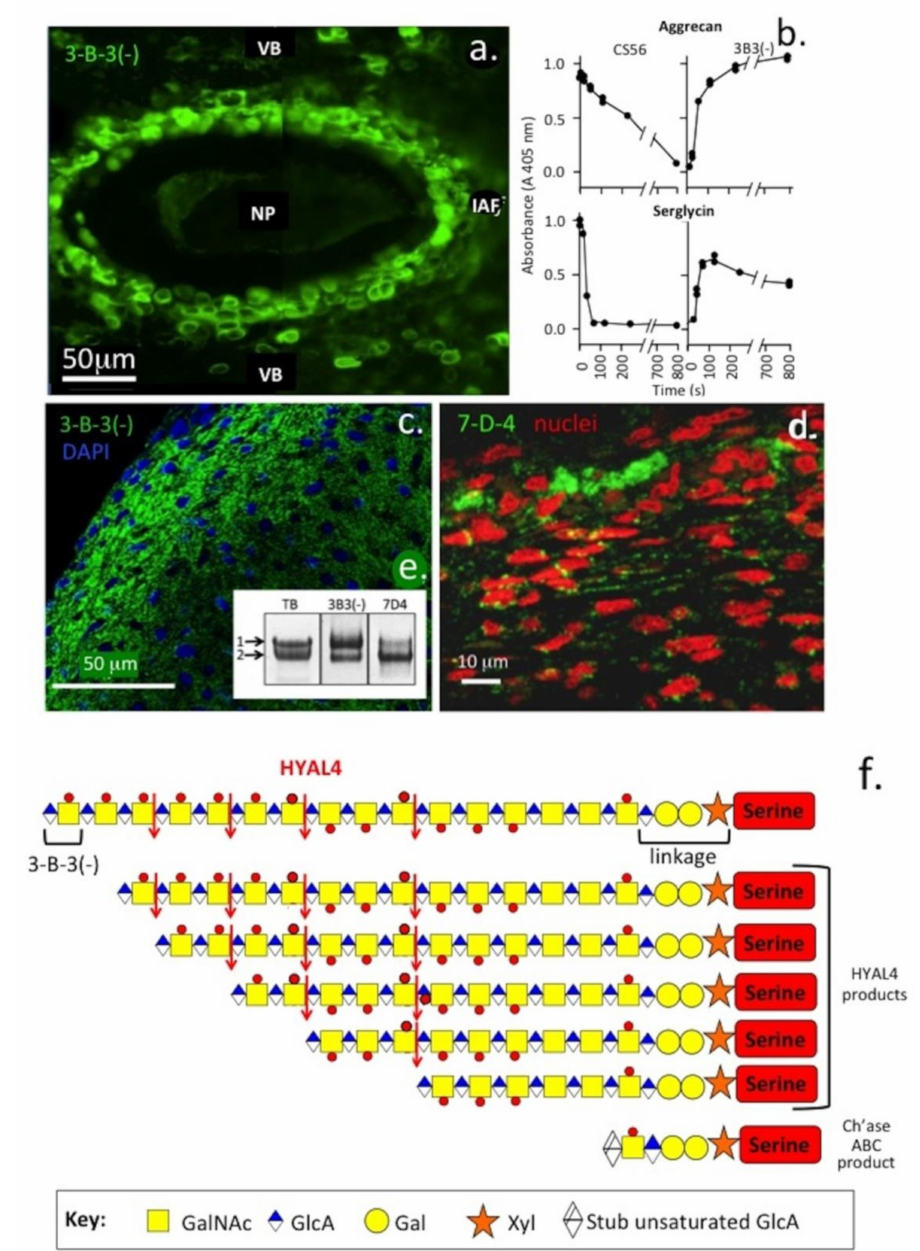
Figure 2. Immunofluorescent localisation of the 3-B-3( − ) CS sulphation motifs on aggrecan associated with rudiment cartilage of a rat intervertebral disc ( a ) and demonstration of the generation of the 3-B-3( − ) epitope by digestion of aggrecan and serglycin as model proteoglycans with hyaluronidase-4 (HYAL4) ( b ). Immunolocalisation of the 3-B-3( − ) and 7-D-4 CS sulphation motifs in developmental human foetal knee joint cartilage (14 weeks gestational age) ( c , d ). The inset of ( e ) shows foetal aggrecan samples separated by native composite agarose polyacrylamide gel electrophoresis and blotted to nitrocellulose for detection of the 3-B-3( − ) and 7-D-4 proteoglycan populations. Two aggrecan populations are discernible. The 3-B-3 ( − ) CS sulphation epitope has a widespread distribution in the developing rudiment cartilage, whereas the 7-D-4 epitope has a more discrete distribution pattern in small stem cell niches in the cartilage surface. A schematic depicting a typical CS chain and digestion products generated by endoglycolytic cleavage by HYAL4 generating the 3-B-3( − ) non-reducing terminal on the cleaved CS chain ( f ). Exhaustive digestion of CS by chondroitinase (Ch’ase) ABC also depolymerises the CS chain but generates a 3-B-3( + ) stub epitope attached to the CS linkage attachment to aggrecan core protein. Inset image ( e ) modified from [50]. ( a , c , d ) Images supplied courtesy of Prof B. Caterson, University of Cardi ff , UK. As already shown in this manuscript approximately ~1–2 in every seven